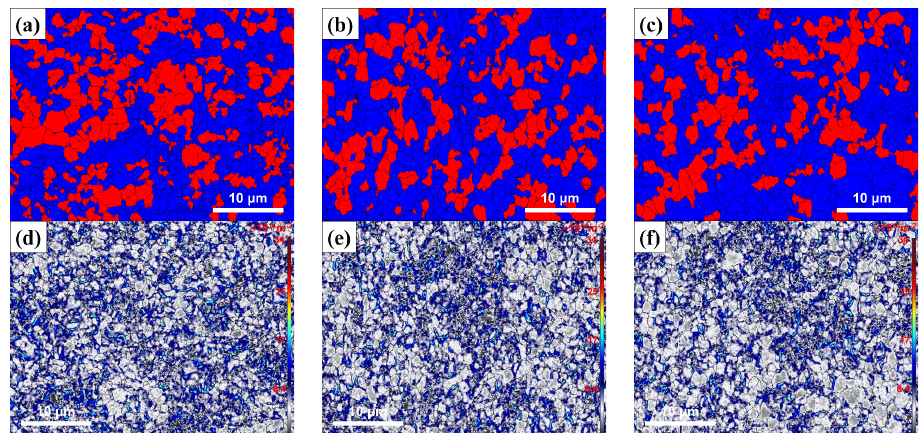
Figure 3. IPF image and grain size distribution of the annealed alloy. ( a , d ) 600 °C; ( b , e ) 700 °C; ( c , f ) 800 °C.